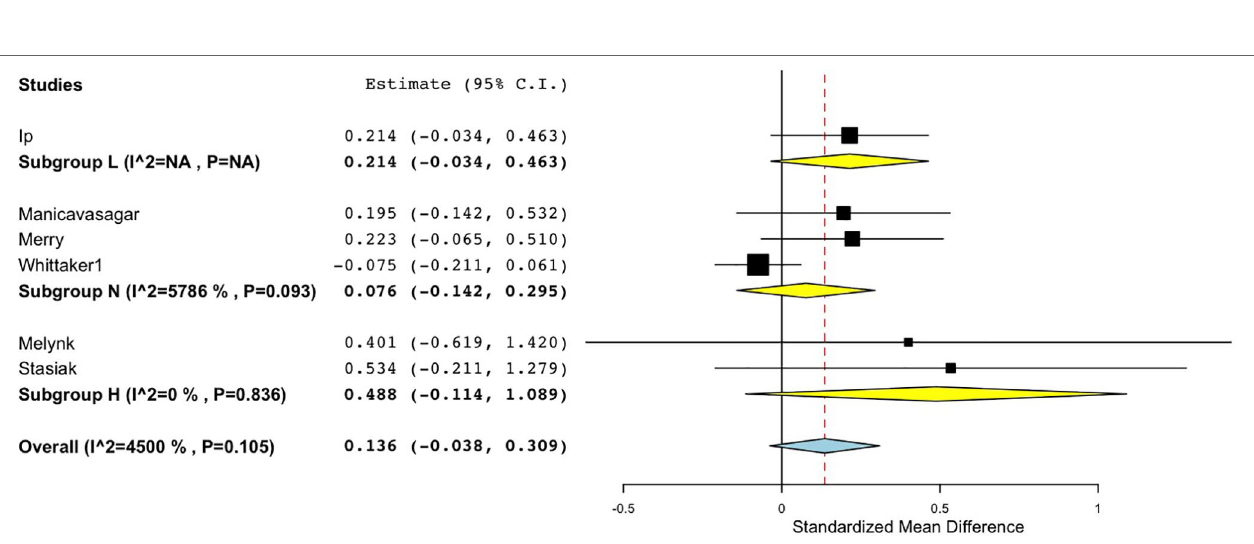
FIGURE 4 | Forest plot of sub-group analysis for randomised controlled comparisons between DMHIs with high, low or no support compared to no intervention for depression in adolescents.